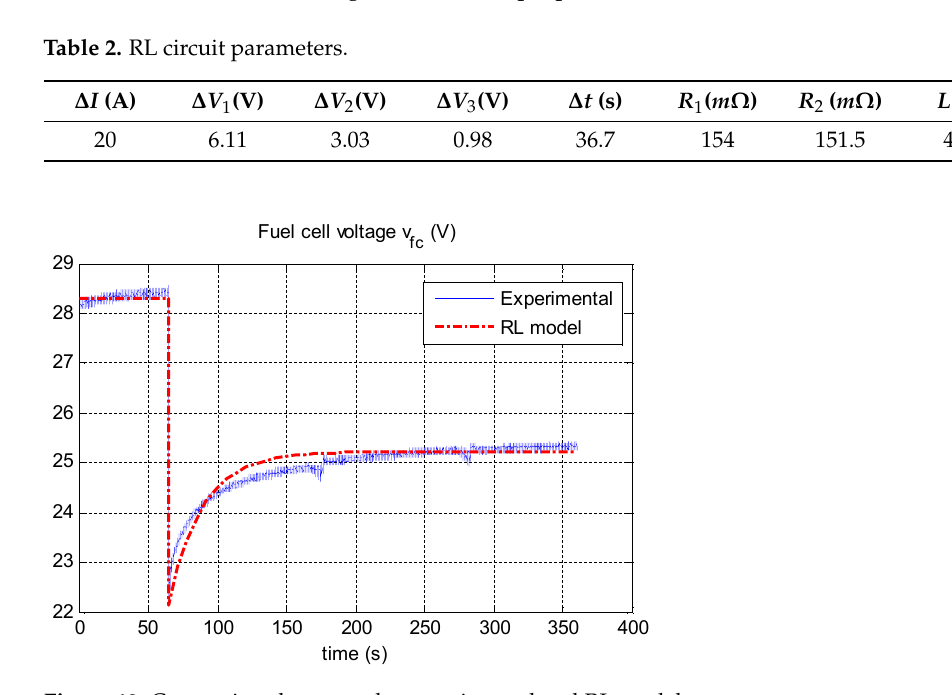
Figure 10. Comparison between the experimental and RL models.